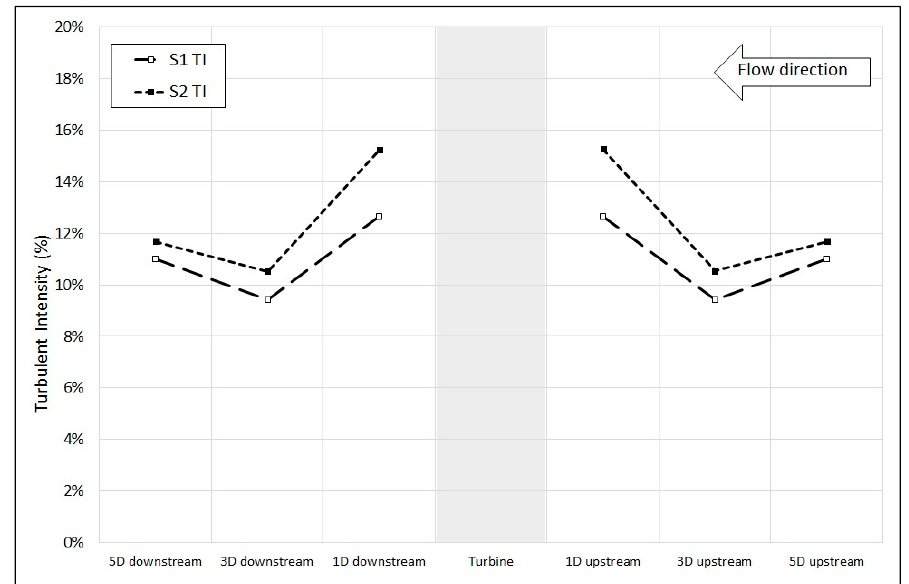
Figure 8. Mean hub height turbulent intensity recorded at 1D, 3D and 5D upstream and 1D, 3D and 5D downstream of turbine mounted on S1 and S2 support structures (4096 samples at 25 Hz per point).